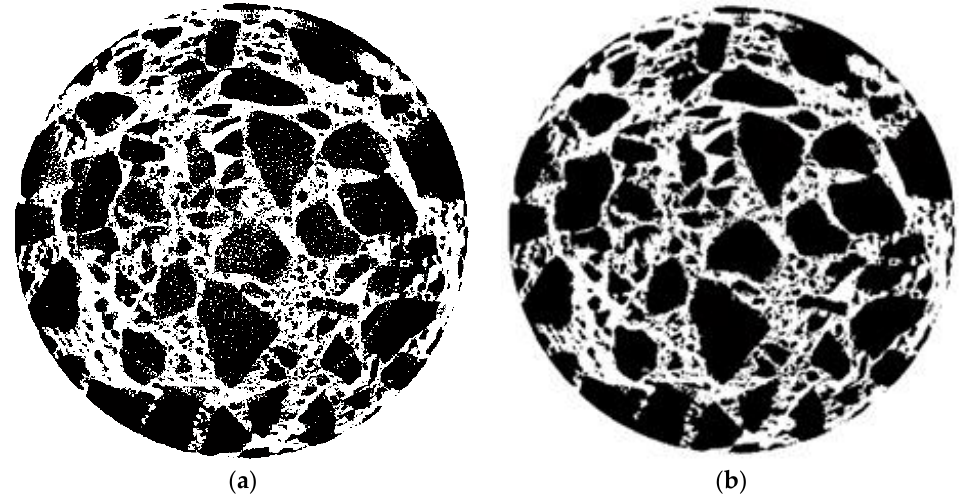
Figure 9. Image after being processed by inverse area filtering. ( a ) Inverted image. ( b ) Filtered image.